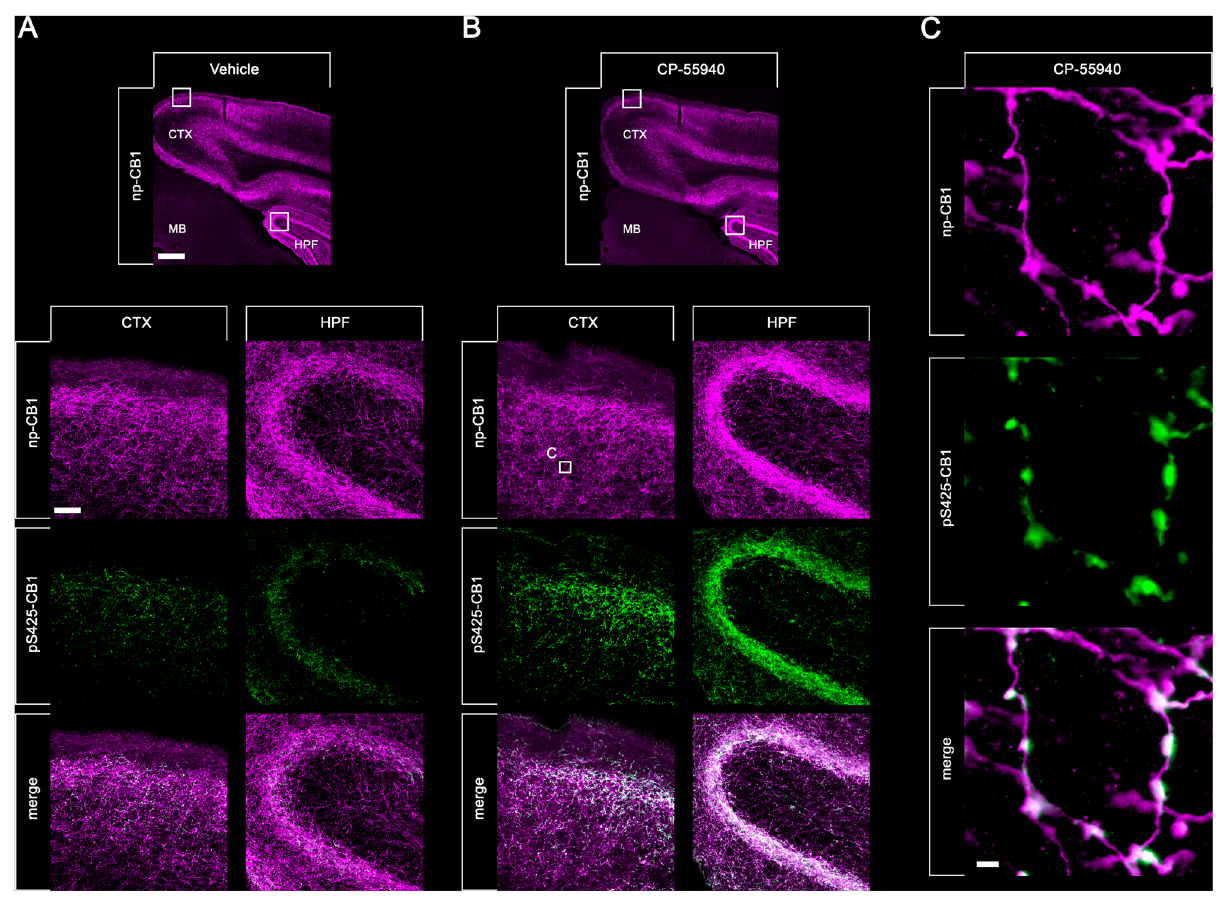
Fig. 10 Double staining of agonist-induced p-CB1 and np-CB1 in mouse brain. Animals were either treated with Vehicle ( A ) or CP-55940 ( B , C ) for 30 min. Animals were then transcardially perfused, fi xed and stained. Shown are confocal images of coronal brain sections of cortex (CTX) and hippocampal formation (HPF) stained with phosphosite-speci fi c antibody pS425-CB1 (green) and phosphorylation independent np-CB1 antibody (magenta). Note that there is a strong overlap of np-CB1 and pS425-CB1 in the merged panels (white) in CP-55940 treated animals ( B ) compared to vehicle treated mice. Note that in cortical neurons, only CB1 located in varicosities undergoes agonist-induced phosphorylation. Scale bar = 1000 µ m, 100 µ m and 2 µ